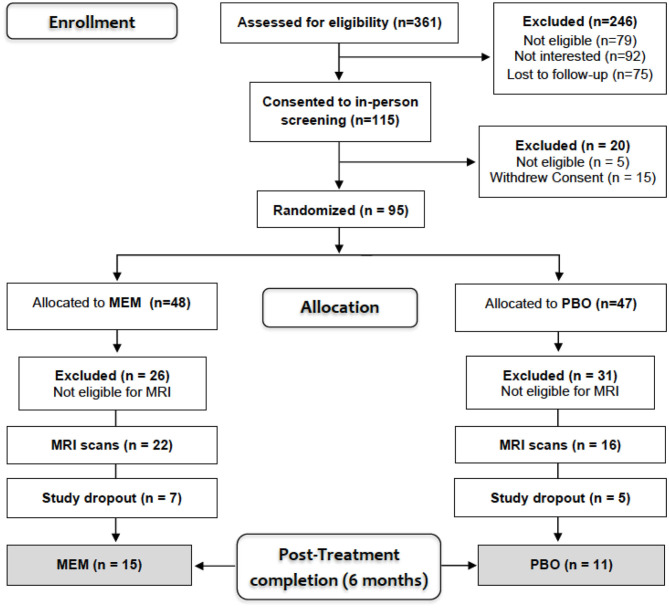
Consort diagram.